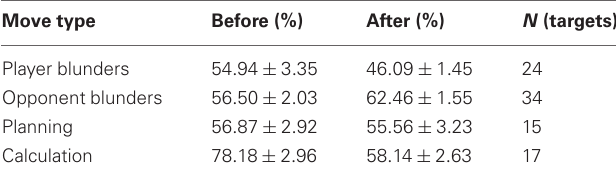
Table 1 | Linear classifier